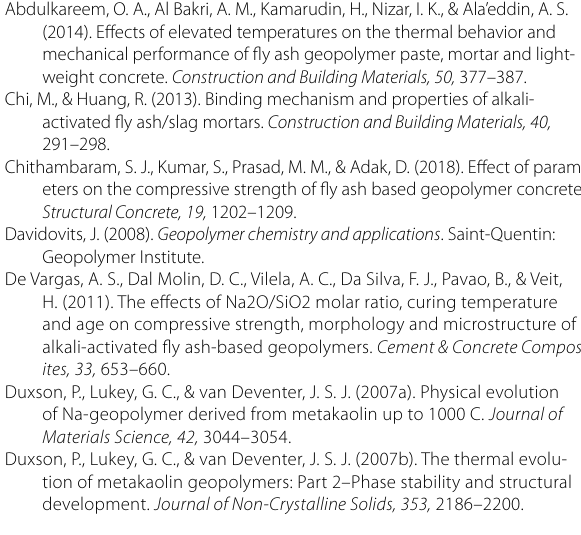
6. Based on theoretical analysis of the results of OED method, the optimum mixture was found as A2B4C1, which represents L/FA ratio at level 2, SHC at level 4 and SS/SH ratio at level 1.